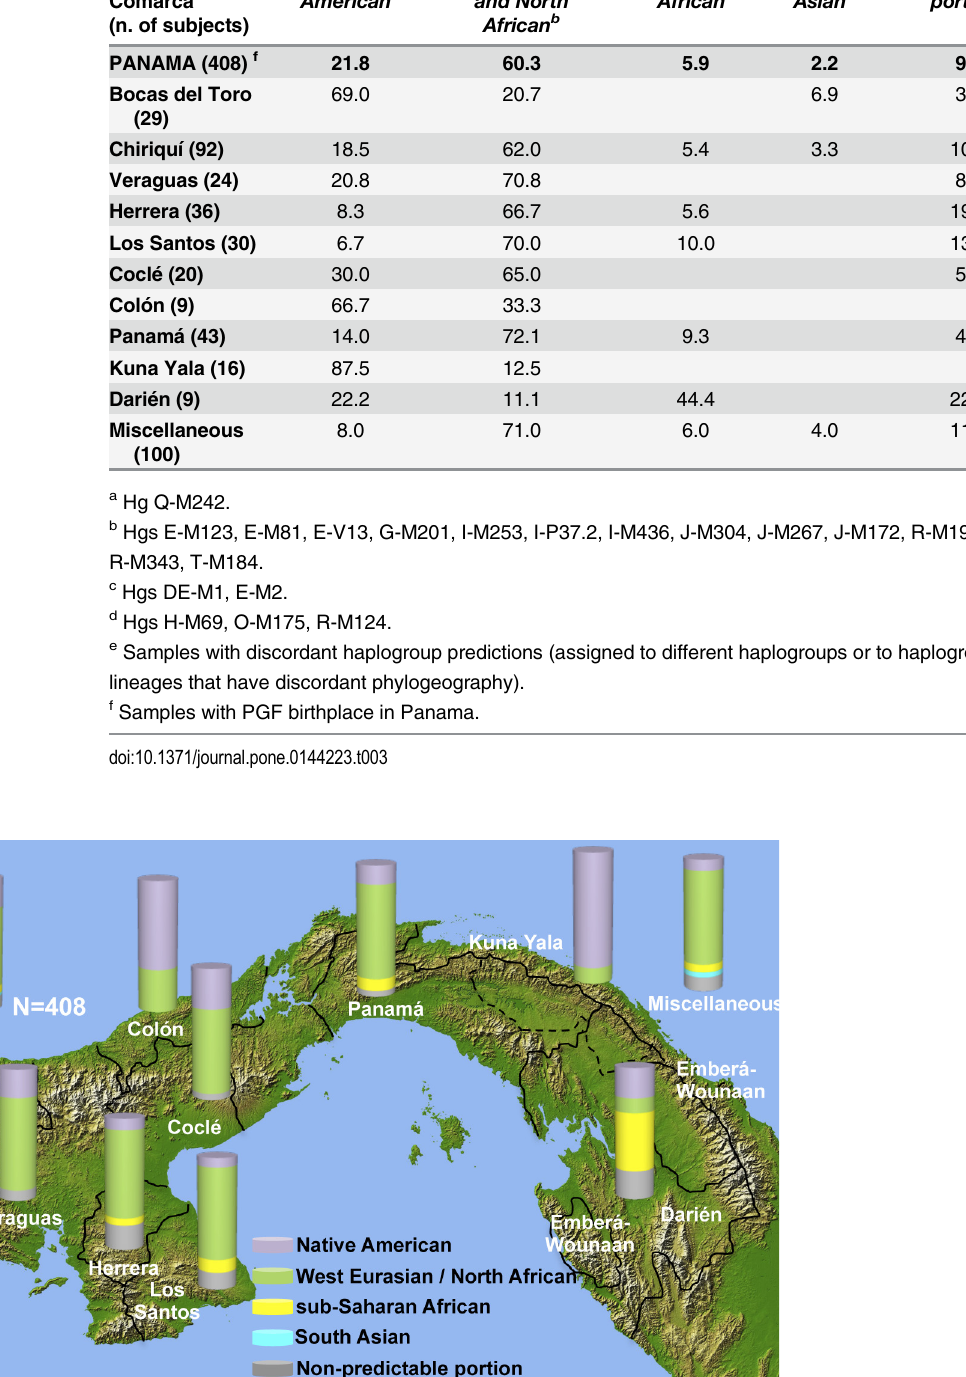
PLOS ONE | DOI:10.1371/journal.pone.0144223 December 4,